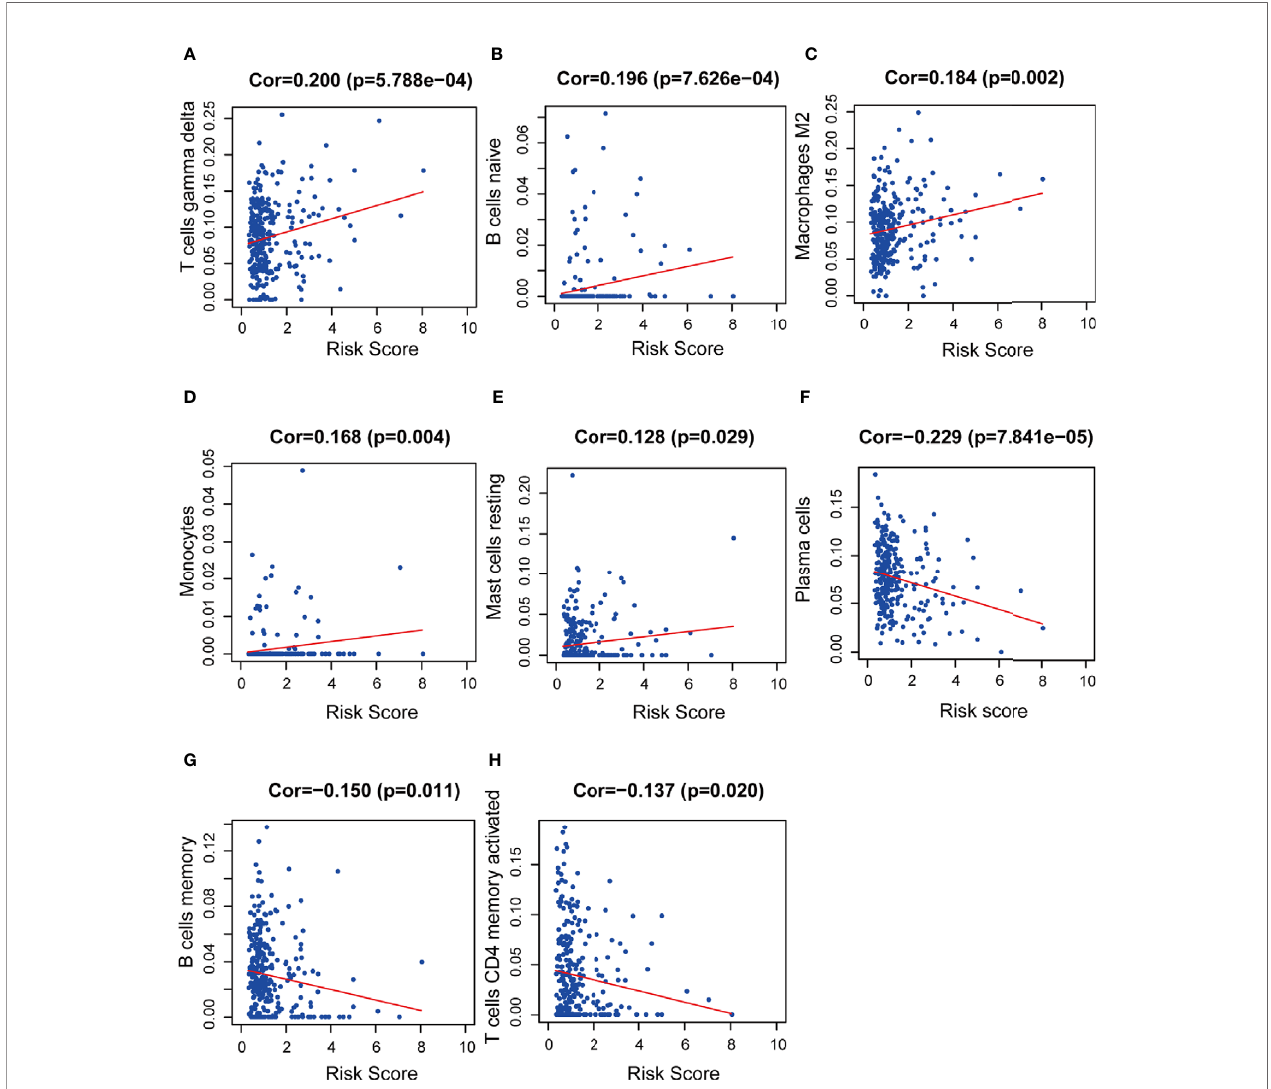
FIGURE 12 | The relationships between the prognostic model and immune in fi ltration estimated by CIBERSORT. The correlation was performed by using Pearson correlation analysis. (A) T cells gamma delta; (B) naïve B cells; (C) M2 macrophages; (D) monocytes; (E) resting mast cells; (F) plasma cells; (G) memory B cells; (H) CD4+ memory activated T